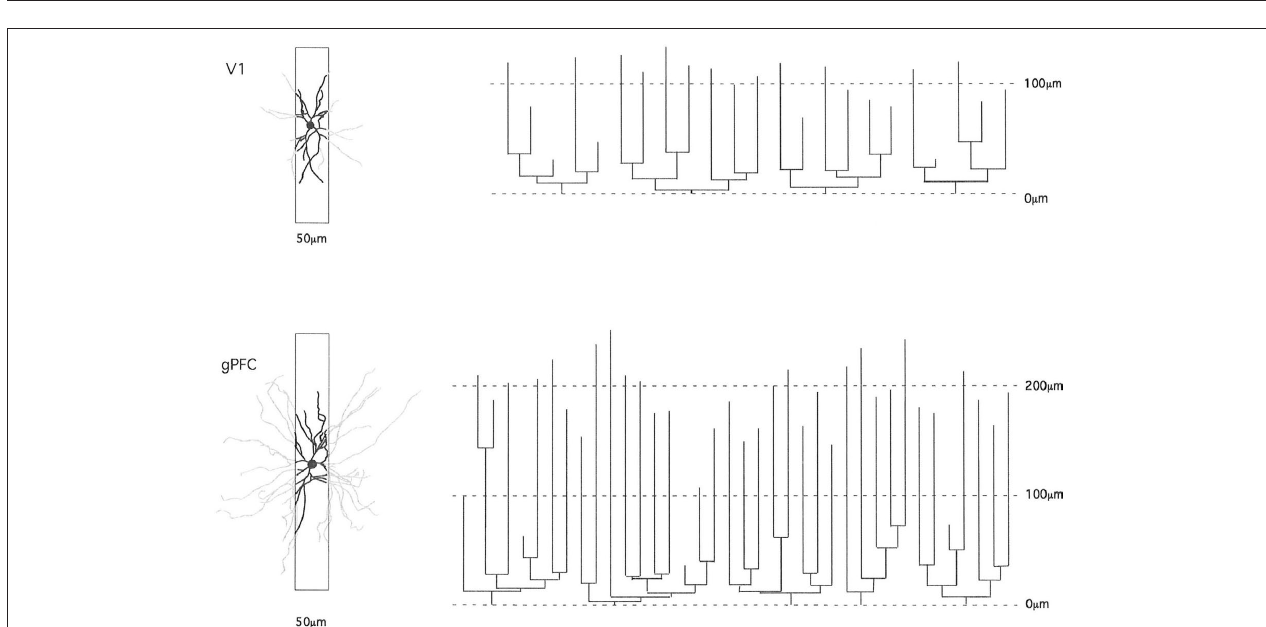
section is illustrated in gray. Note the relative similarity in structure of the part of the dendritic tree revealed in the 50-μm transverse sections. At right are illustrated the dendrograms of each of the two cells, which resulted from reconstruction of the complete basal dendritic tree as seen in the tangential plane. Based on our observations, transverse sections would have to be of the order of 1 mm thick to include all dendrites (e.g., human temporal lobe; Elston et al.,